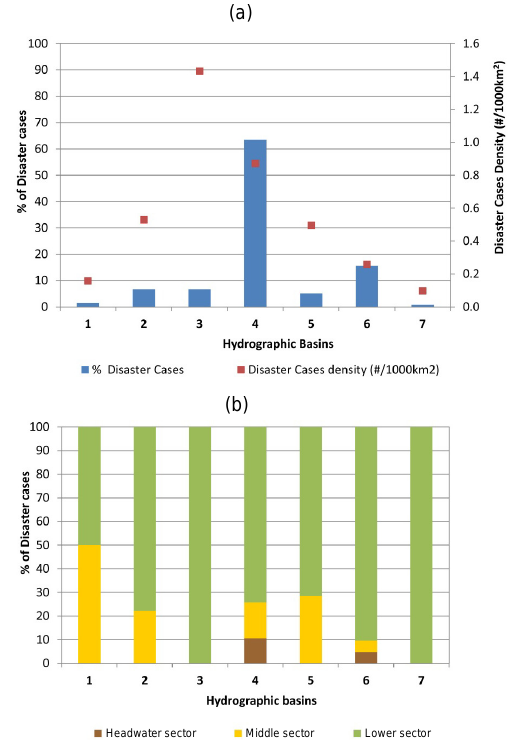
Figure 2. Percentage of Disaster cases and Disaster cases density per hydrographic basin (a) and percentage of Disaster cases per hy- drographic basin sector (b) . Hydrographic basin code: 1 – Coruña basins; 2 – Minho Basin; 3 – Lima and Cávado basins; 4 - Douro Basin; 5 – Águeda, Mondego and West basins; 6 – Tagus Basin; 7 – Sado